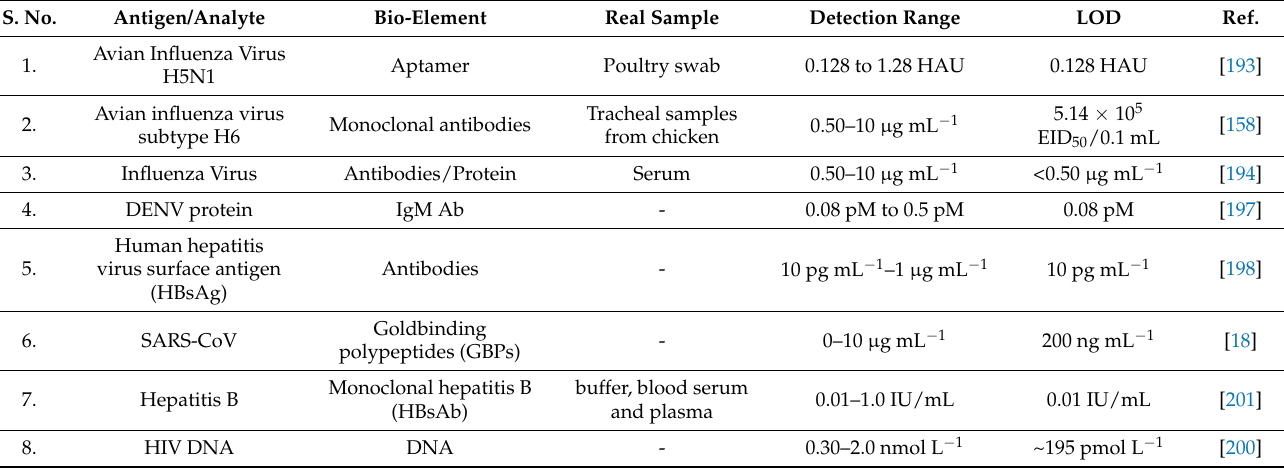
Figure 5. ( A ) Principle of SPR biosensor for detection of AIV H5N1: ( a ) Streptavidin immobilization; ( b ) Biotinylated apTable; ( c ) Virus detection. 2012. @MDPI [193]); ( B ) Schematic illustration of the SPR signal before and after the analyte flow (Adapted from Omar et al., Scientific Reports, 2020 [197] ); ( C ) Schematic demonstration for the preparation of DNA–AgNP conjugates through one-step conjugation chemistry and a sandwich strategy for HIV DNA detection. Red (DNA1) and green (DNA2) strands represent 2 probe DNAs that can hybridize with HIV DNA (Adapted with permission from Liu et al., Analyst, 2012 [200] ). Table 3. Reported SPR-based sensing platform for viral infection.